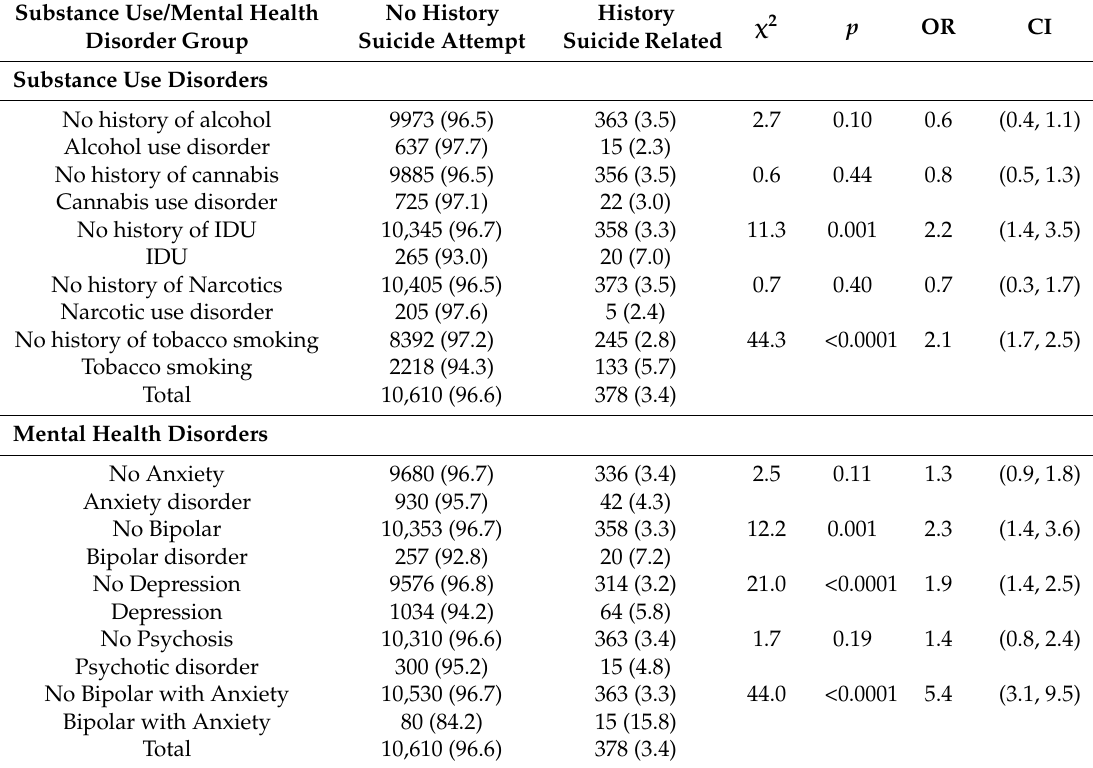
Table 5. Percent suicide attempt by substance use and mental health